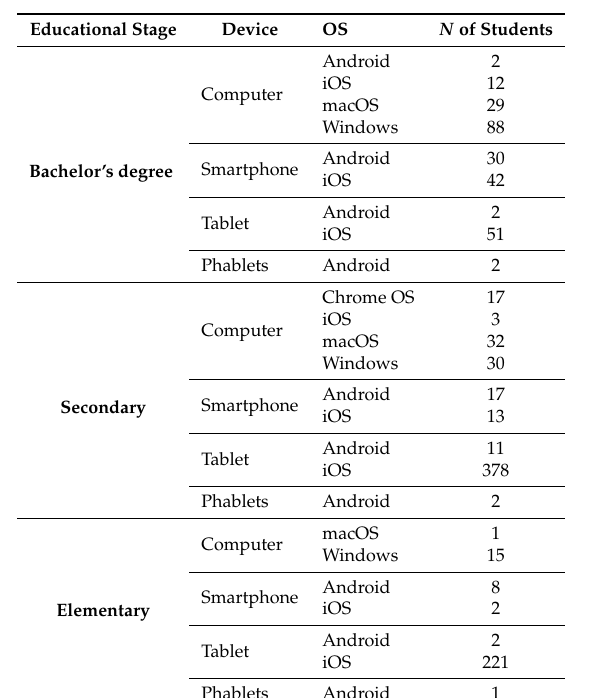
Table 2. Number of students per device and operating system disaggregated by different educational stages (Bachelor’s degree, Secondary and